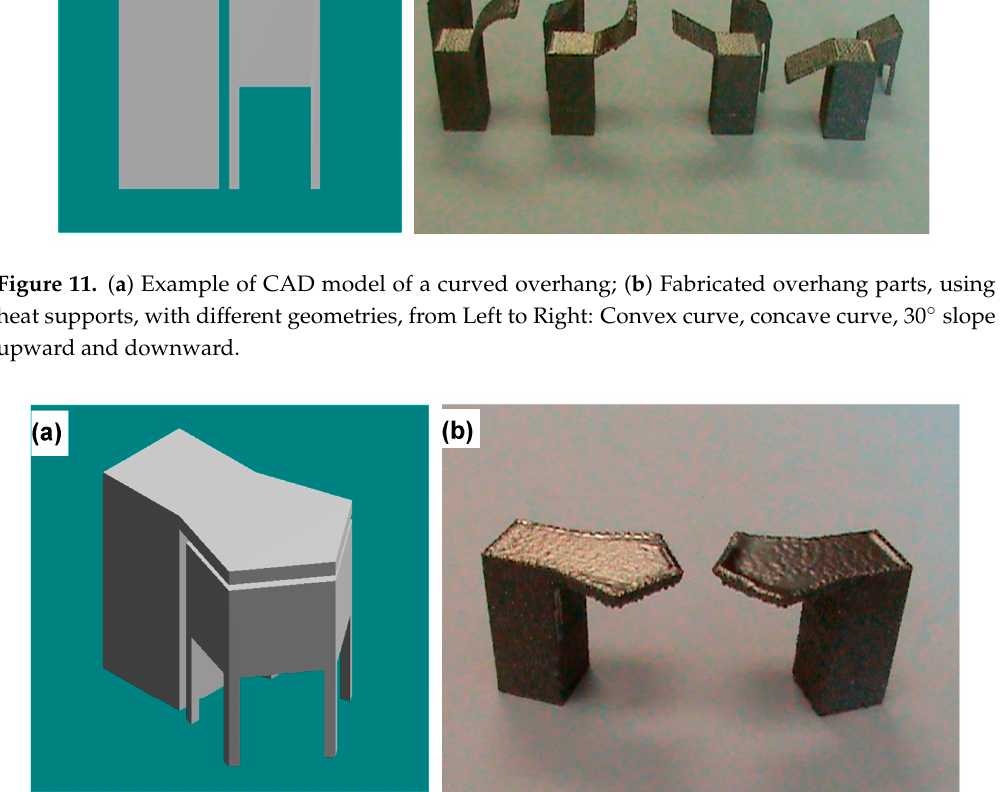
Figure 12. ( a ) CAD model of pentagon-shaped overhang. ( b ) Fabricated overhang: with (Left) and without heat support (Right).